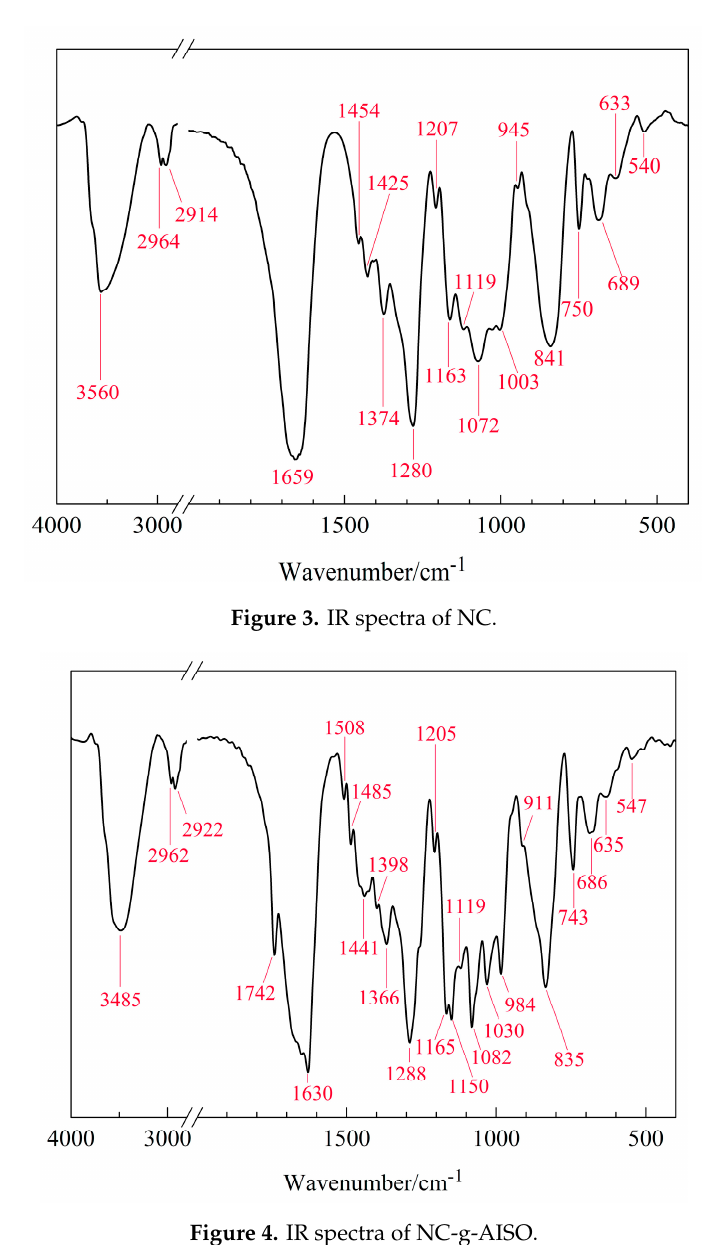
Figure 5. 13 C NMR spectra of NC. The 13 CNMR spectra of NC-g-AISO are shown in Figure 6. It shows all the peaks which belong to the carbon atoms of NC with a slight chemical shift. At the same time, the spectra of NC-g-AISO show carbon of the carboxylate ester group at δ 174.22 ppm, the carbons of benzene rings and C=N in the oxazine ring at δ 157.25–107.13 ppm, the quaternary carbon of spirooxazine moieties at δ 51.93 ppm, the carbons of dimethyl linked with quaternary carbon at δ 24.82 and 20.07 ppm and the carbons of the polyolefin chain at δ 24.17 and 21.82 ppm. The carbon peak of N-CH 3 overlaps with solvent at 29.20 ppm, while the spiro carbon peak at 99.50 ppm submerged in that of C-1 of the NC